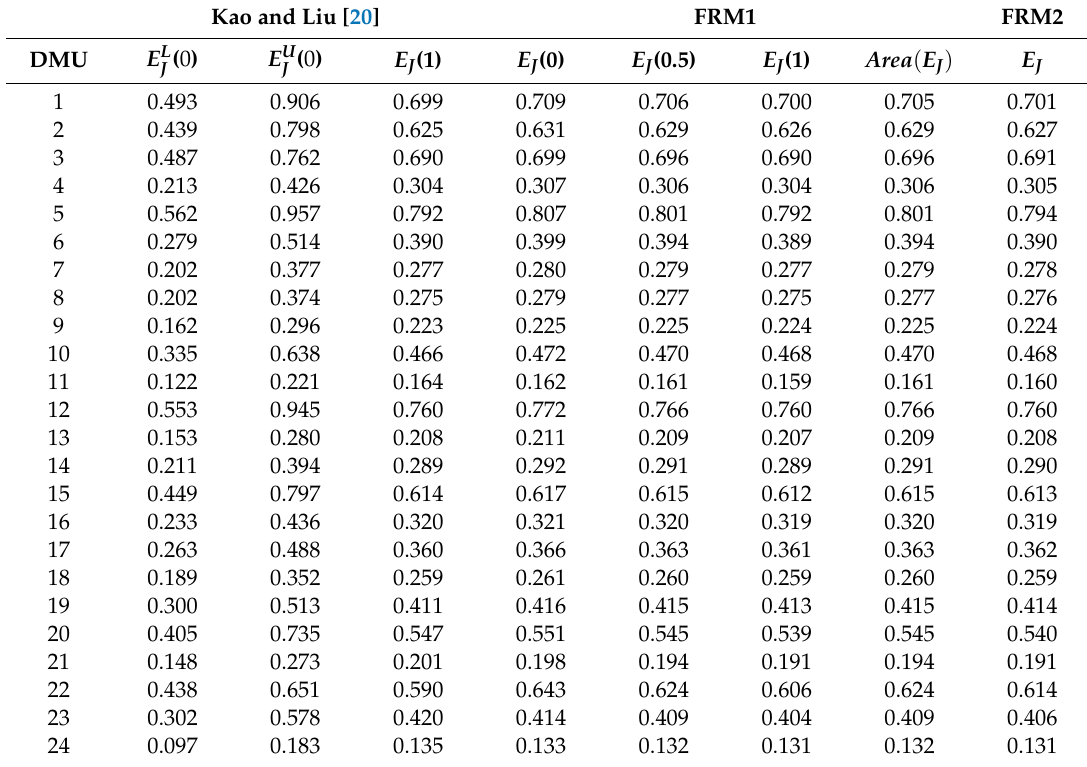
Table 1. E ffi ciency estimates of proposed approaches for dataset